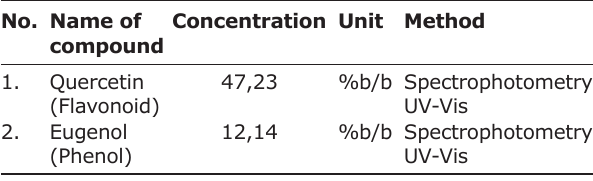
Table-1: Bioactive compounds with the largest composition contained in the ethanolic extract of Ocimum sanctum